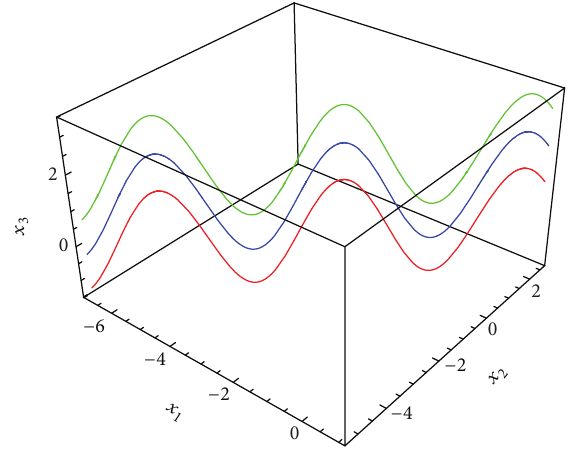
Figure 1: Integral curves.